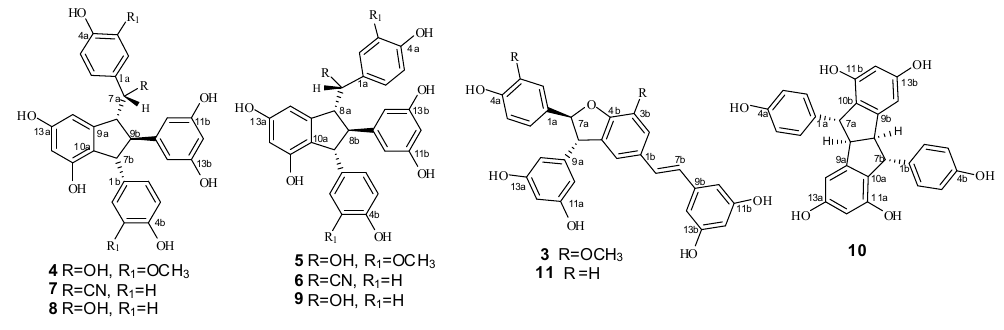
Figure 1. Structures of compounds 3 – 11 .